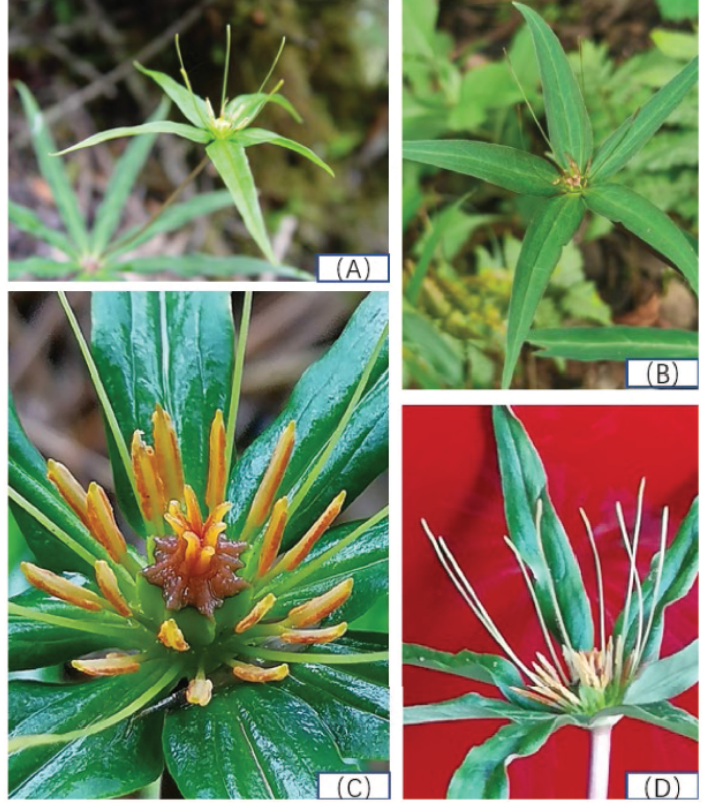
Fig. 3 Paris panxiensis flower: (A) flower, (B) sepal, (C) stamen and pistil and (D) petal.